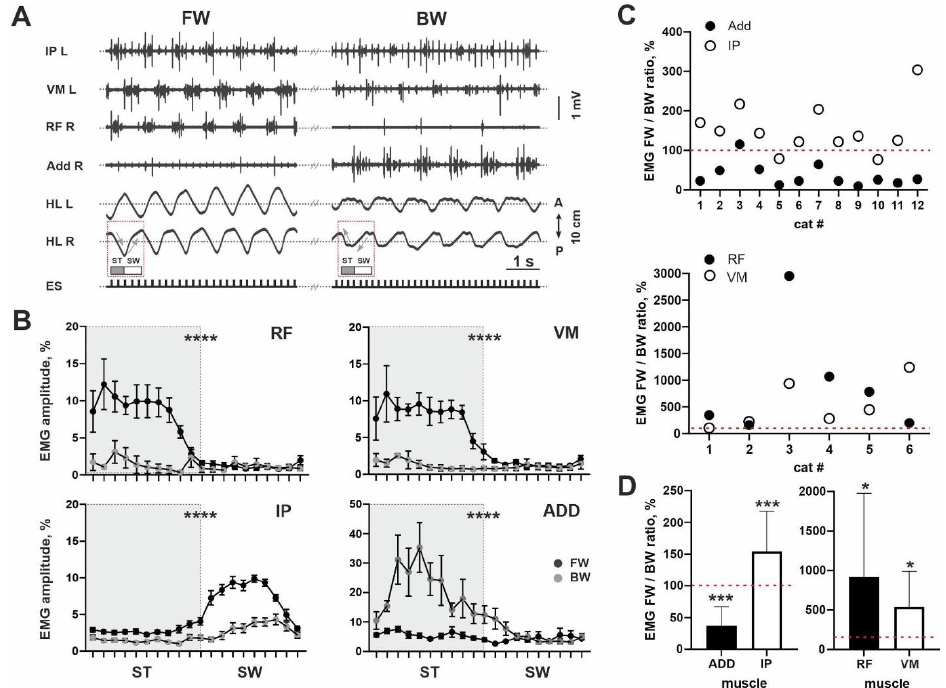
Figure 2. Muscle activity during FW and BW stepping. ( A ) Representative example of the EMG activity of the m. iliopsoas (IP), m. rectus femoris (RF), m. vastus medialis (VM) and m. adductor magnus (ADD) during the same registration. A, P—anterior and posterior directions of the hindlimb. SW—swing, ST—stance. HL L and HL R—left and right hindlimbs. ES—stimulation; light gray arrows mark hindlimb movements. ( B ) Averaged percent EMG activity during step cycle, for FW (dark gray) and BW (light gray) stepping. OX axis, step cycle. ( C ) Individual percent ratio in the muscle activity during FW and BW stepping, for ADD and IP (top) and RF and VM (bottom). OX axis, individual cats. ( D ) Averaged percent ratio in the muscle activity during FW and BW stepping. OX axis, muscles. * p < 0.05; *** p < 0.001; **** p < 0.0001.